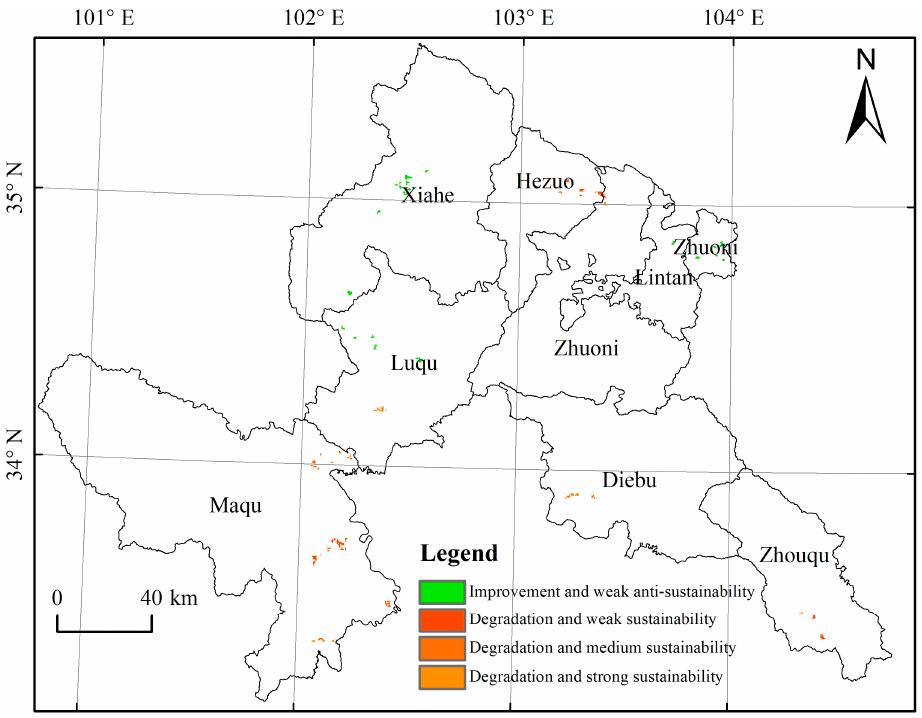
Figure 8. Areas with present degradation and future sustainability trends during 2000–2020.